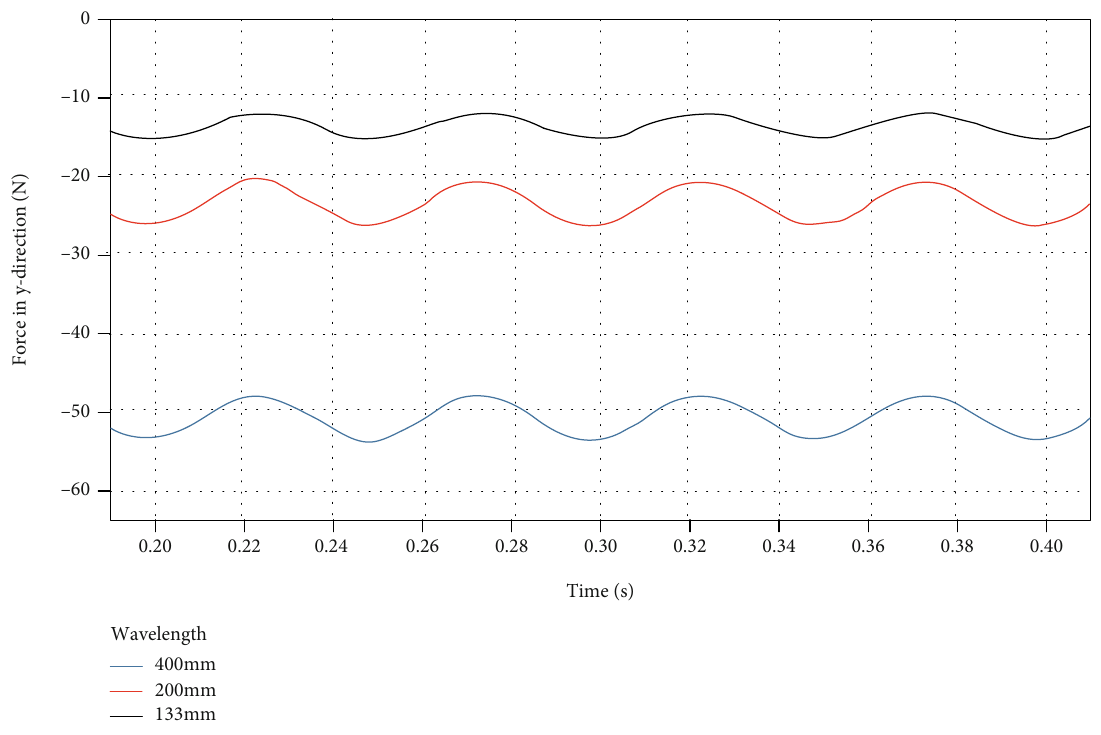
Figure 15: y -direction force on the dorsal fi n at di ff erent wavelengths.